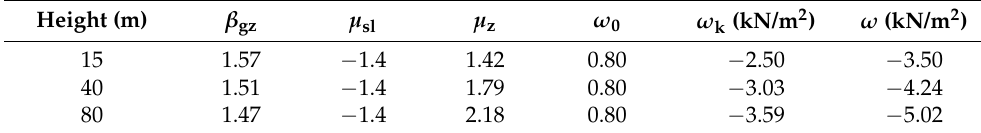
Figure 5. Setup for the wind suction test.